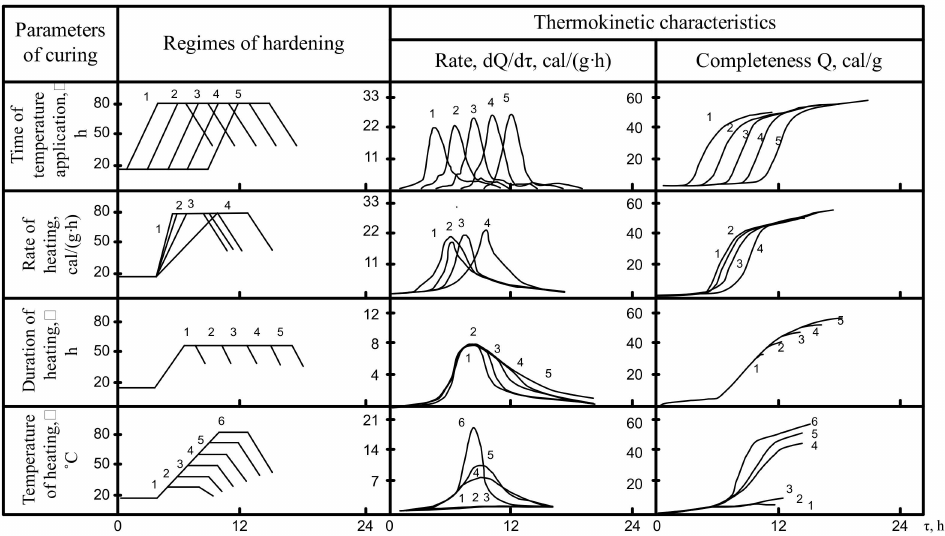
Figure 7. The influence of heat curing parameters on thermokinetic characteristics of the cement hydration in the slag + clinker + solution of Na 2 O · SiO 2 · 5H 2 O